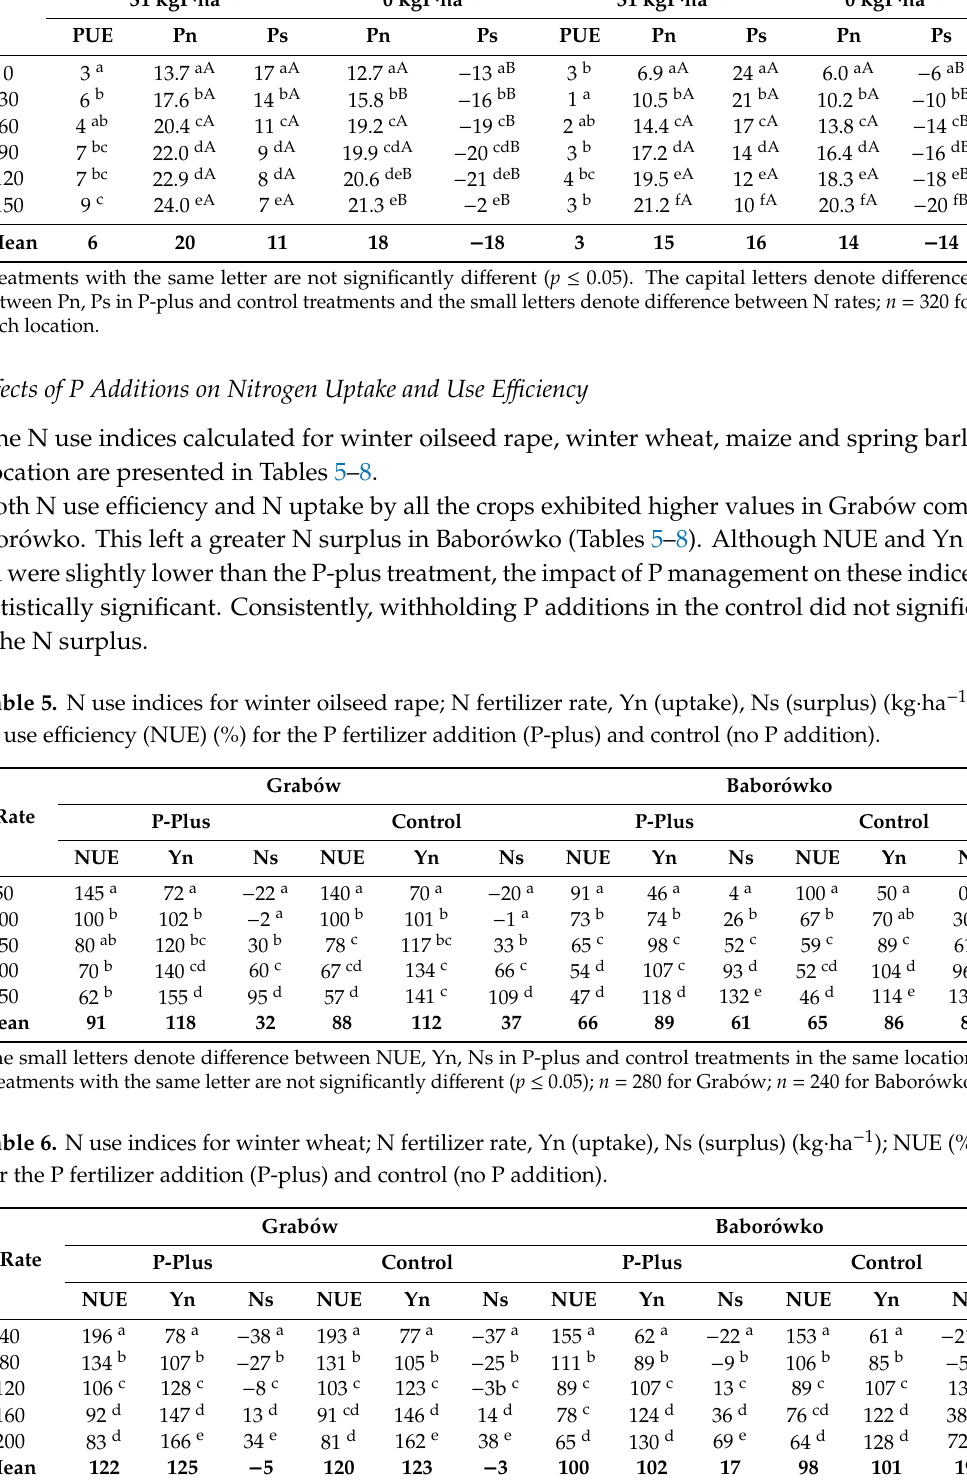
Table 4. P use indices for spring barley; N fertilizer rate; P fertilizer rate; Pn (uptake) and Ps (surplus) (kg · ha − 1 ); PUE (%).